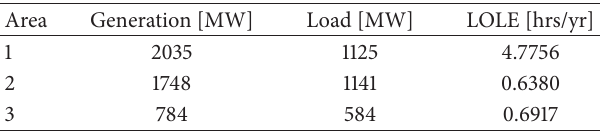
Figure 3: Flowchart of firm and nonfirm ATC determination technique. Table 1: Generation, load, and LOLE for the three areas.